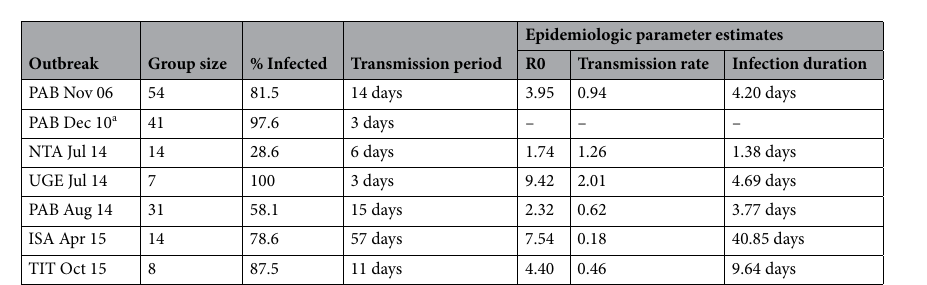
Figure 1. Predicted eigenvector centrality for all individuals in ( A ) contact and ( B ) proximity annual social networks (2004–2015), based on age and sex (F: female or M: male) from GAMMs. Solid lines indicate predicted values, grey shading indicates 95% confidence interval, circles indicate individual data points. ( C ) Predicted eigenvector centrality based on age/sex categories and adult male dominance from linear mixed models in both the contact (black) and proximity (grey) networks. Error bars indicate standard error.